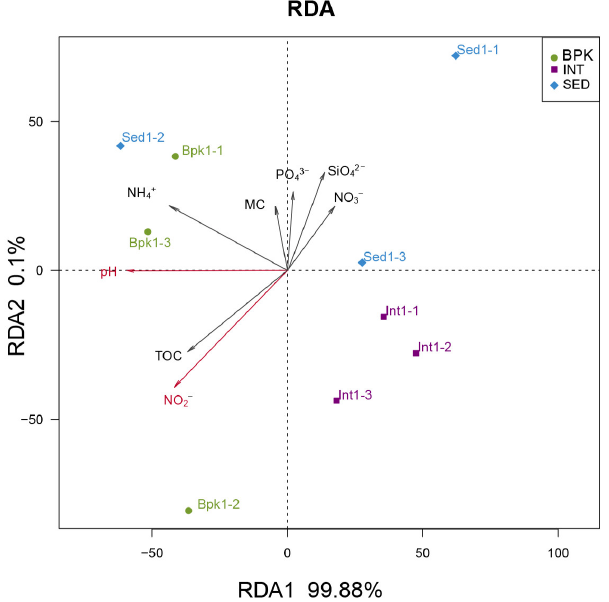
Figure 5. Redundancy analysis of archaeal community. Dots with different colors represent different sampling sites, arrows represent geochemical properties, and the longer the length, the greater the correlation between the geochemical property and the sample distribution. Table 3. A Monte Carlo permutation test for geochemical properties and archaeal community.